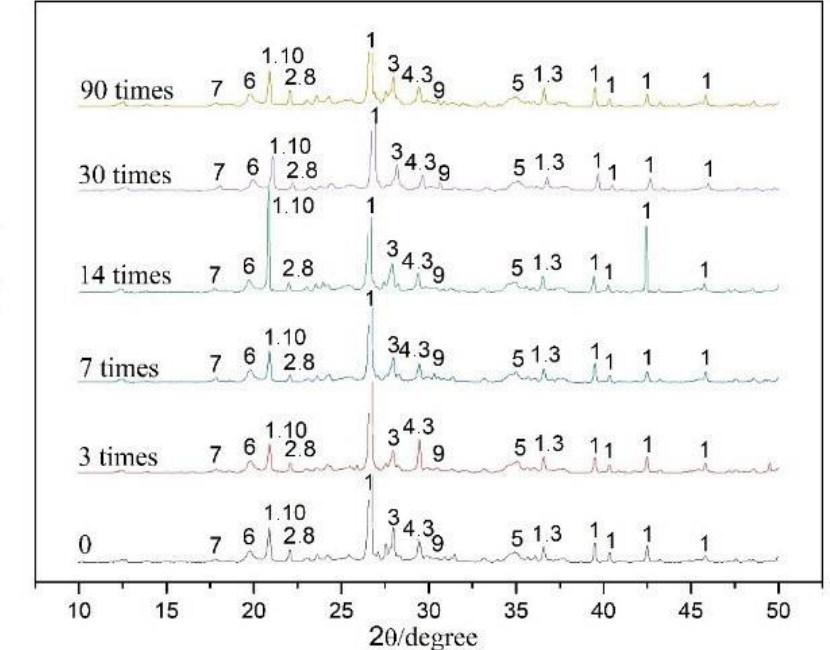
kinds of F-T cycles: 0, 3, 7, 14, 30, and 90